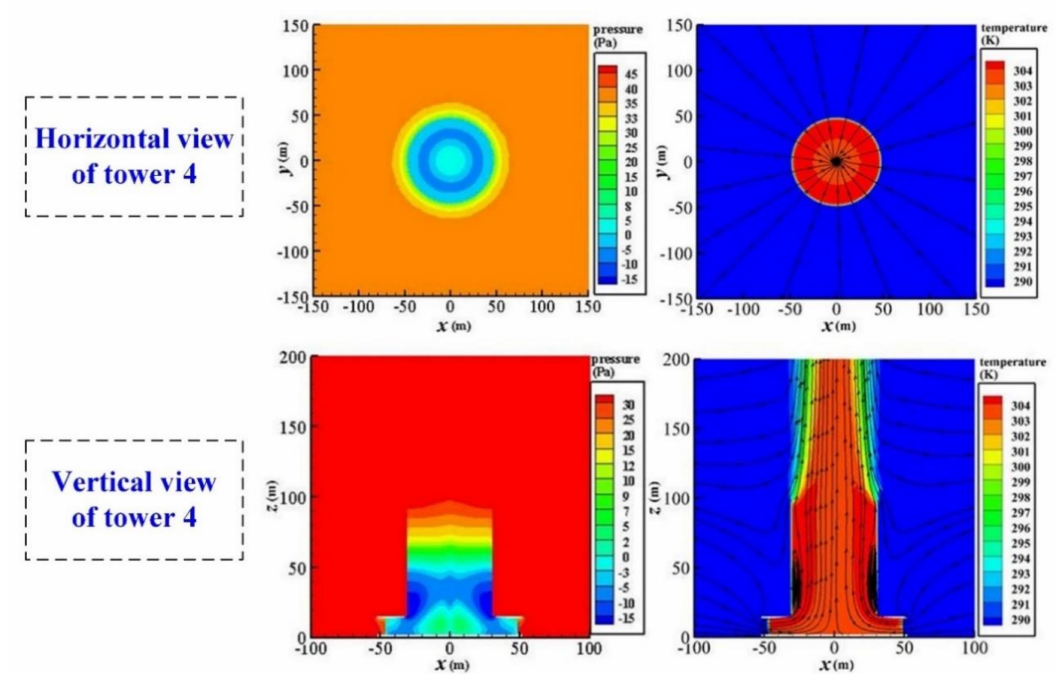
Figure 9. Air variable contours for steel-truss NDDCS with cylindrical tower configuration without ambient